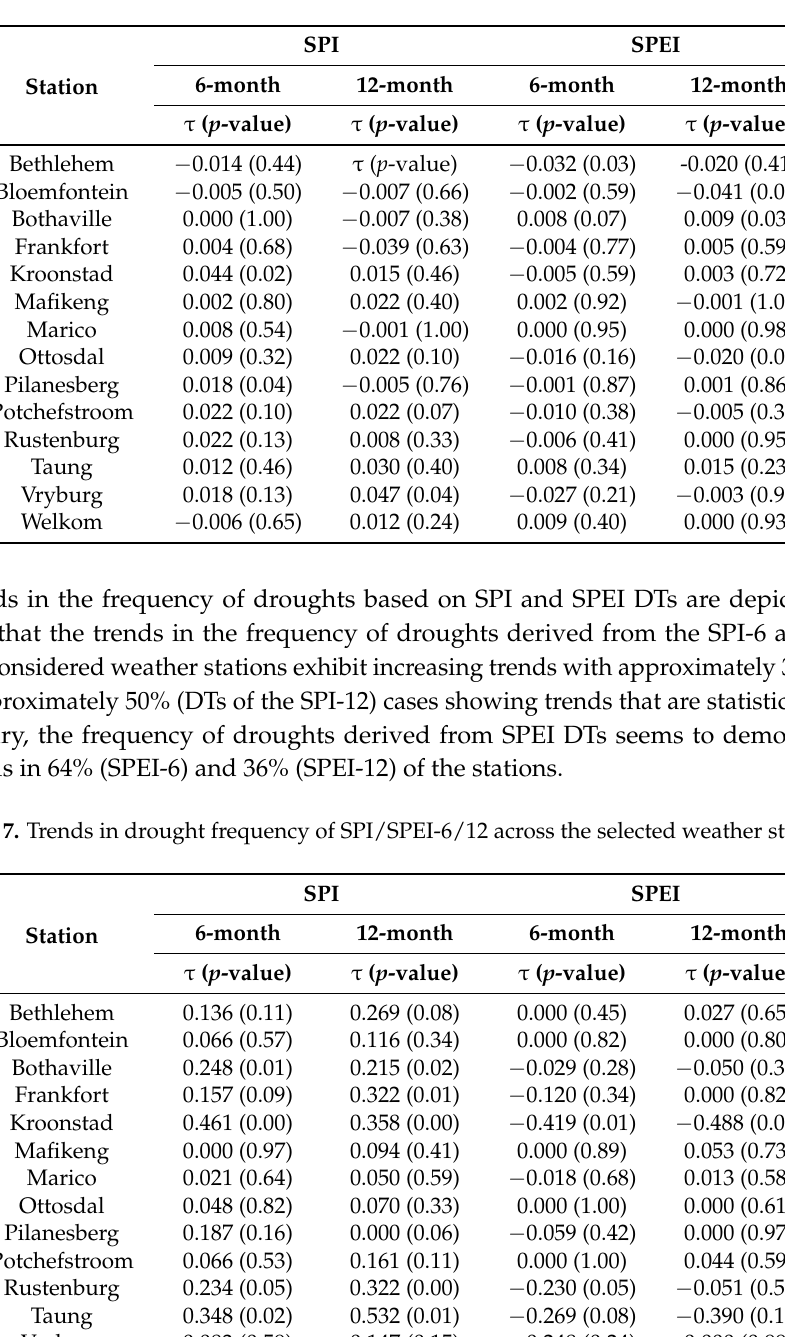
Table 6. Trends in drought intensity of SPI-6 and SPEI-12 across the selected weather stations.